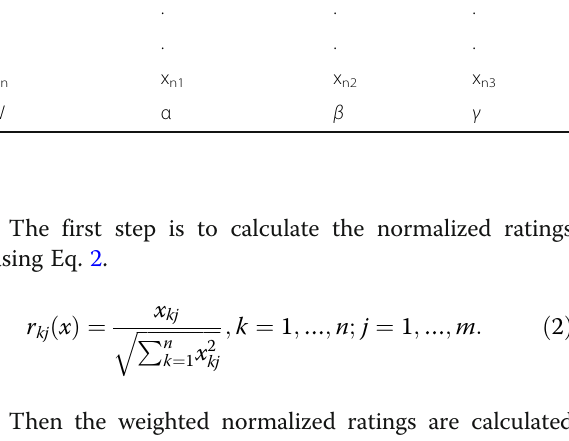
Criteria Similarity